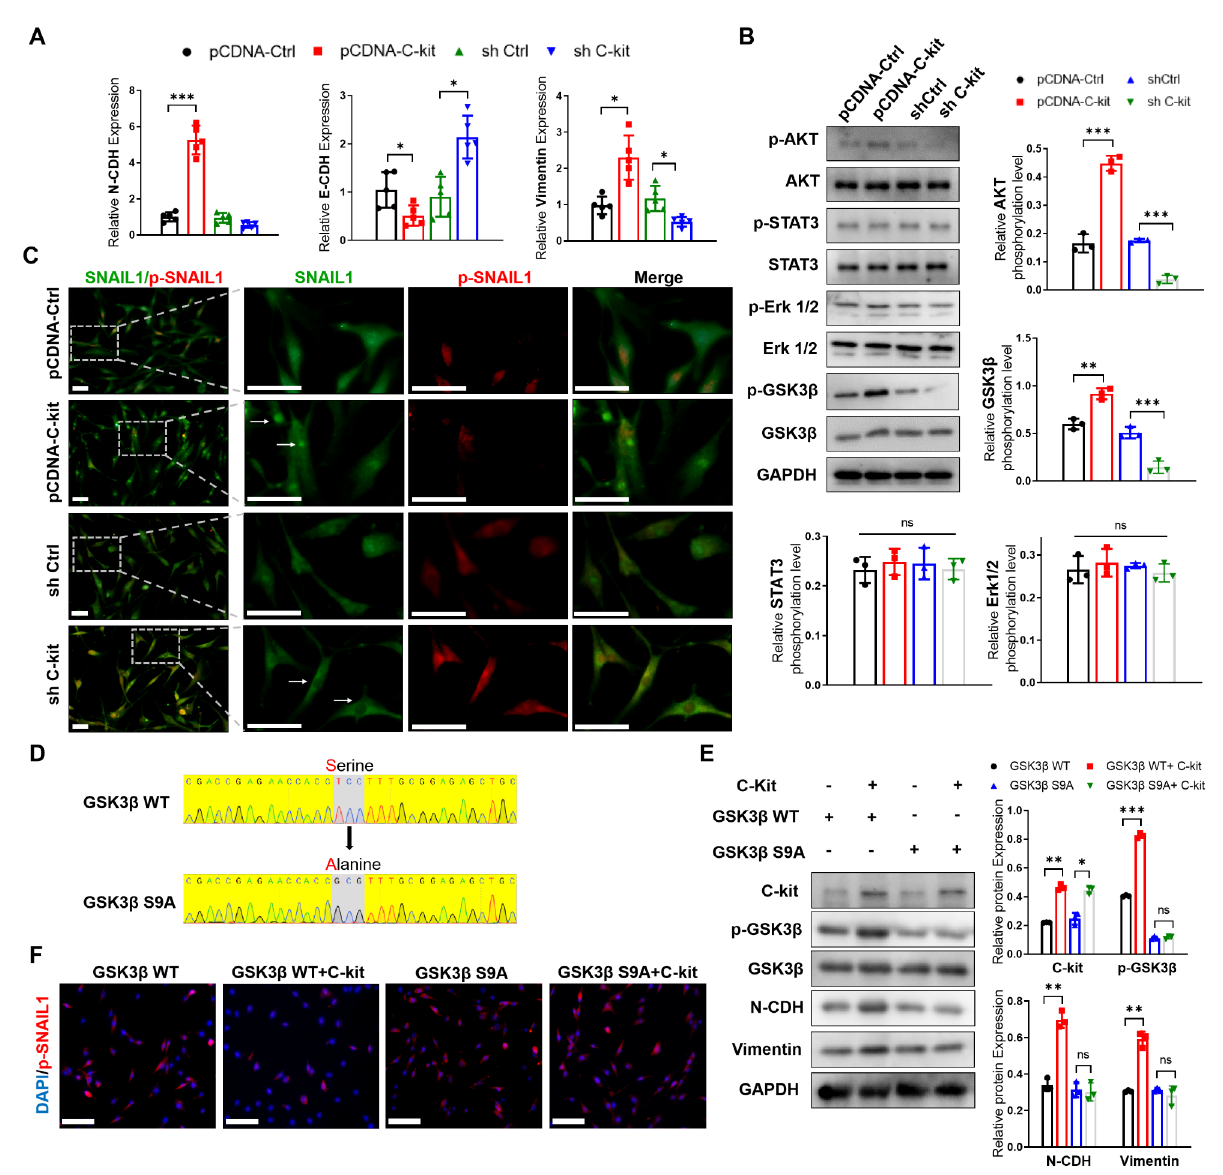
Fig. 7 Mechanism diagram C-kit drives EMT signaling in OA-FLSs and promotes a destructive FLS phenotype, leading to synovial inflammation and cartilage